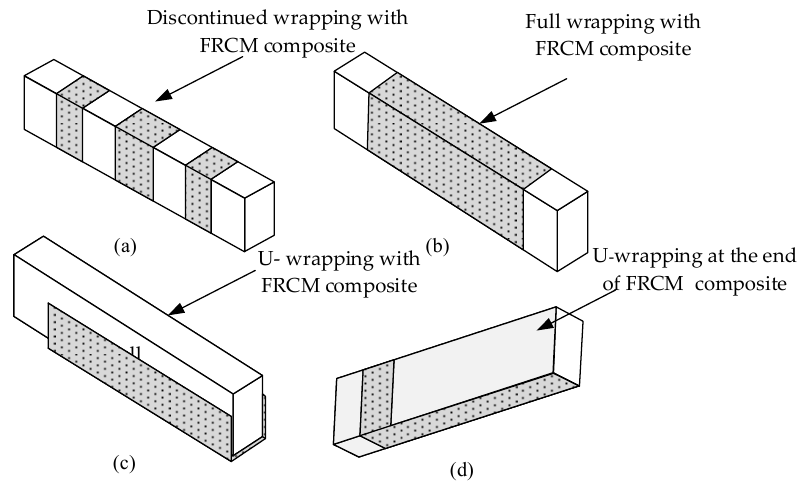
Figure 2. Different methods for strengthening beams: ( a ) discontinuous wrapped beam; ( b ) entire wrapped beam; ( c ) U-wrapped beam; ( d ) strengthened beam in tensile face with U-end anchorage.